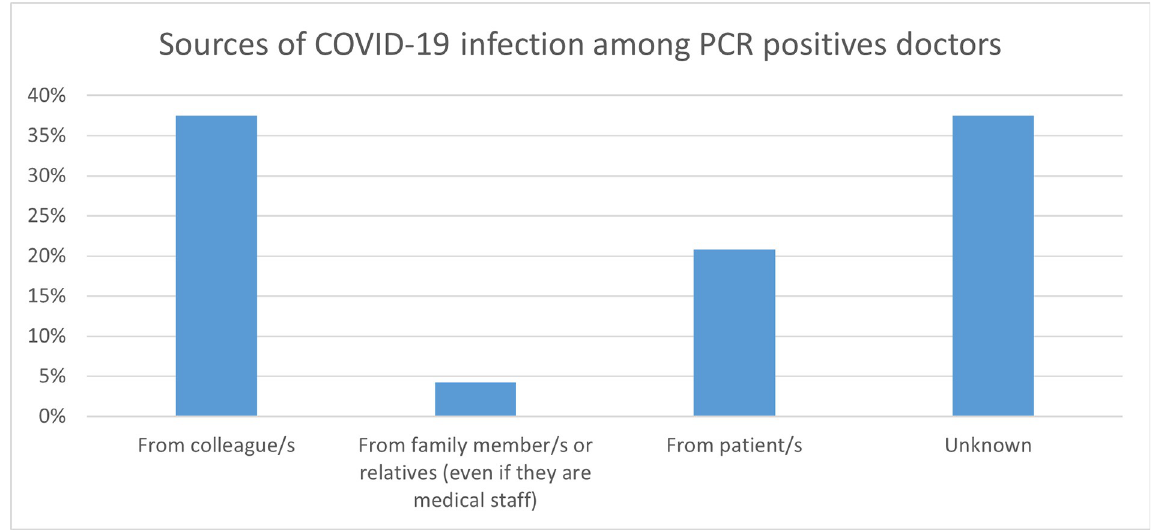
Fig 1. Source of COVID-19 infection among the doctors who had ever tested positive for COVID-19 infection before.